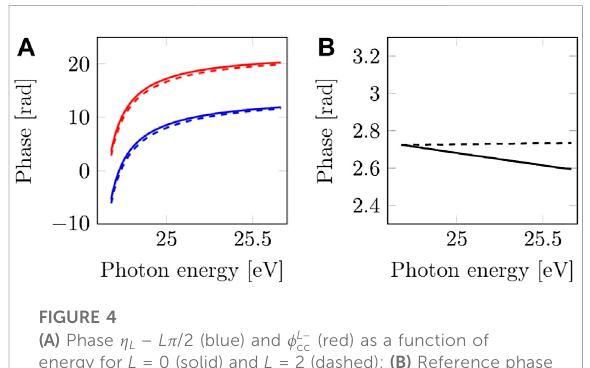
cc (red) as a function of